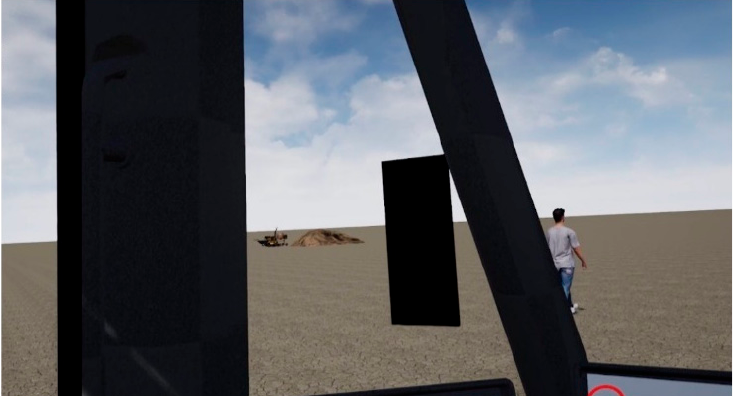
Figure 10. View from the left window showing a distant construction activity.